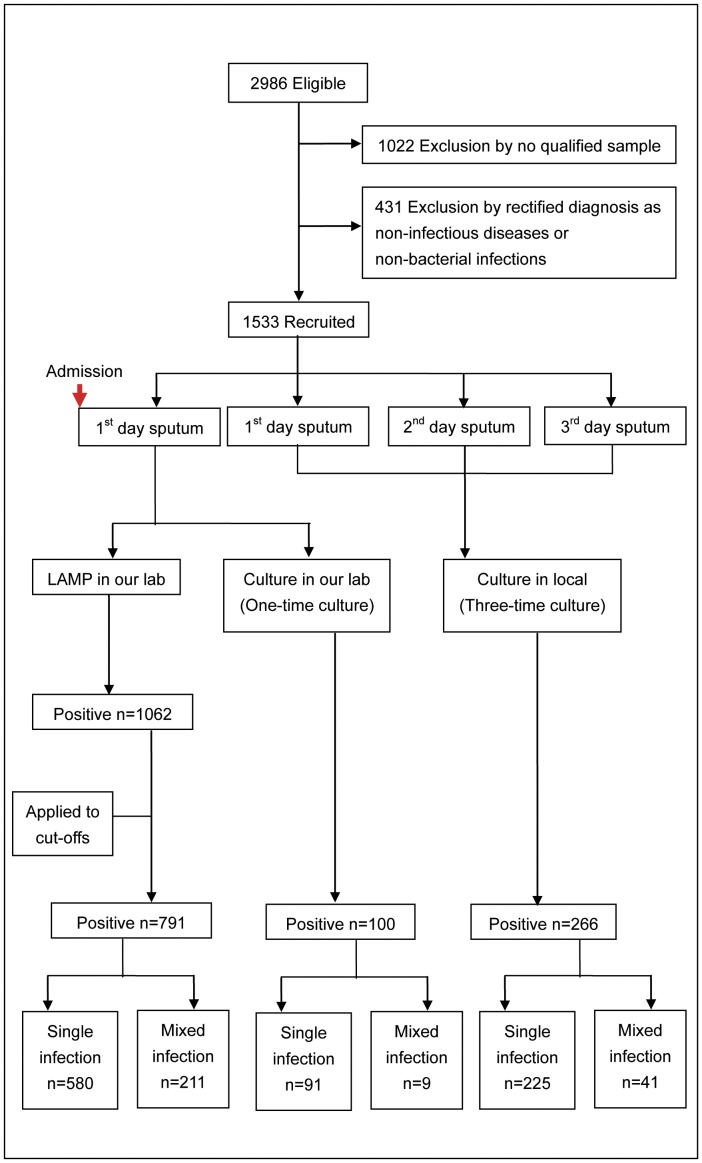
A flow chart of patient recruitment and sample processing.After admission, we collected 4 sputum samples from each patient. The same samples are used for the parallel qLAMP and culture tests. The results from qLAMP and one-time culture are from the same sample, and those of qLAMP and three-time culture are from the same patient, but not the same sample.